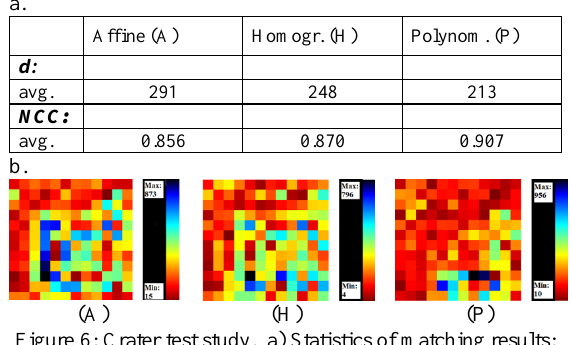
Figure 6: Crater test study. a) Statistics of matching results; b) Colour Map of the distances d for each shape model